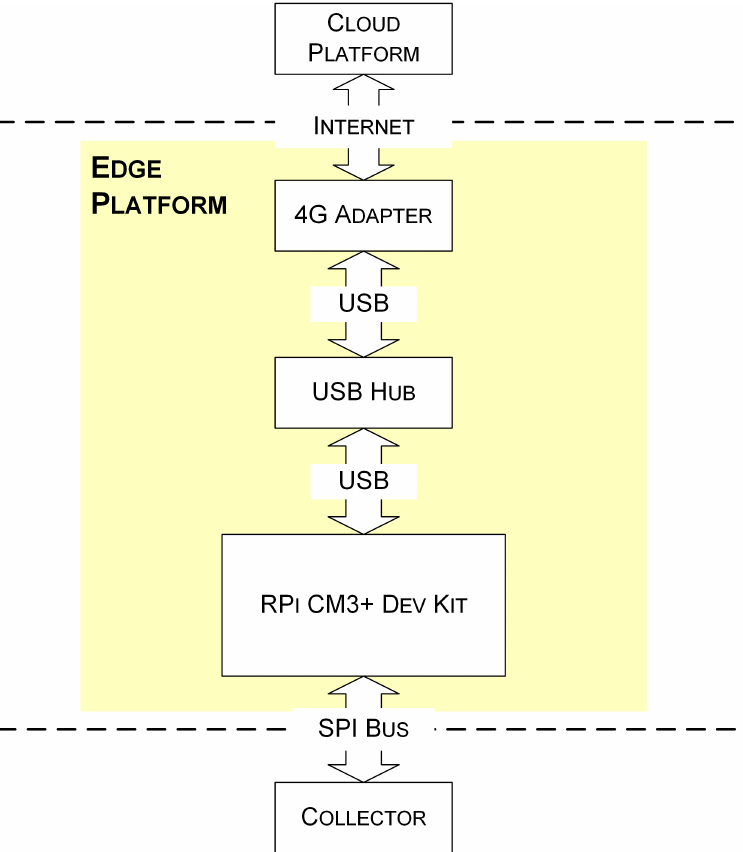
Figure 3. Components of the edge